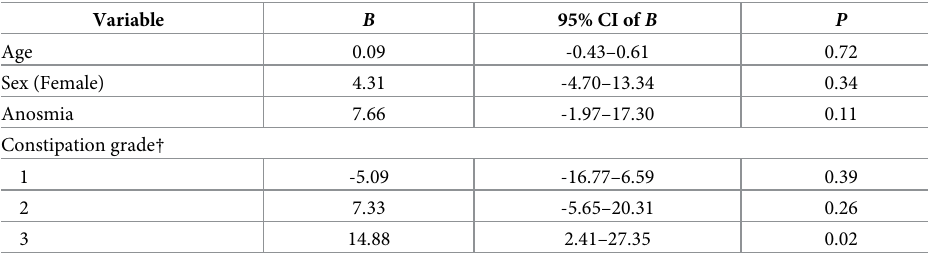
Table 4. Multiple linear regression analysis on MDS-UPDRS total